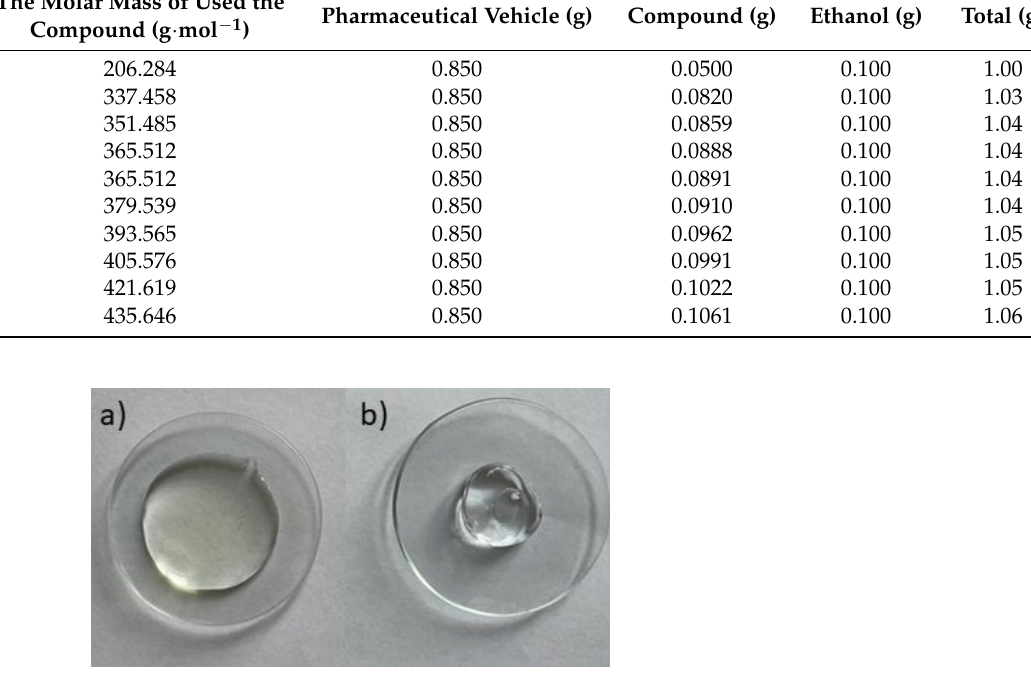
Figure 1. The appearance ( a ) of the vehicle used for this research and ( b ) a commercial product.